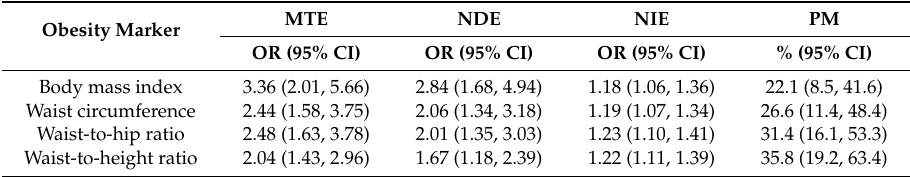
Table 4. Counterfactual mediation of diet quality (AHEI) in the association of educational level with obesity markers, menuCH, Switzerland,